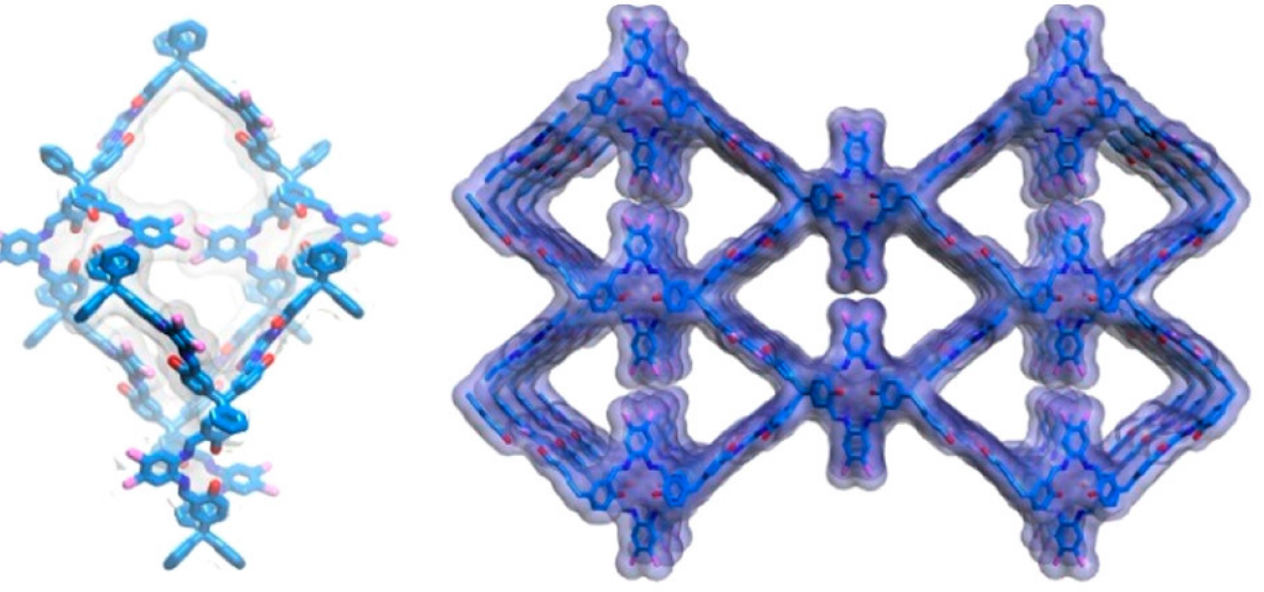
Figure 17. Structural representation of JUC-509. Reprinted (adapted) with permission from [60]. Copyright 2019 American Chemical Society.